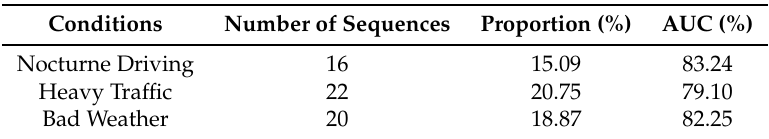
Table 1. The performance on the three special conditions, involving the scenarios with nocturne driving, heavy traffic and bad weather.